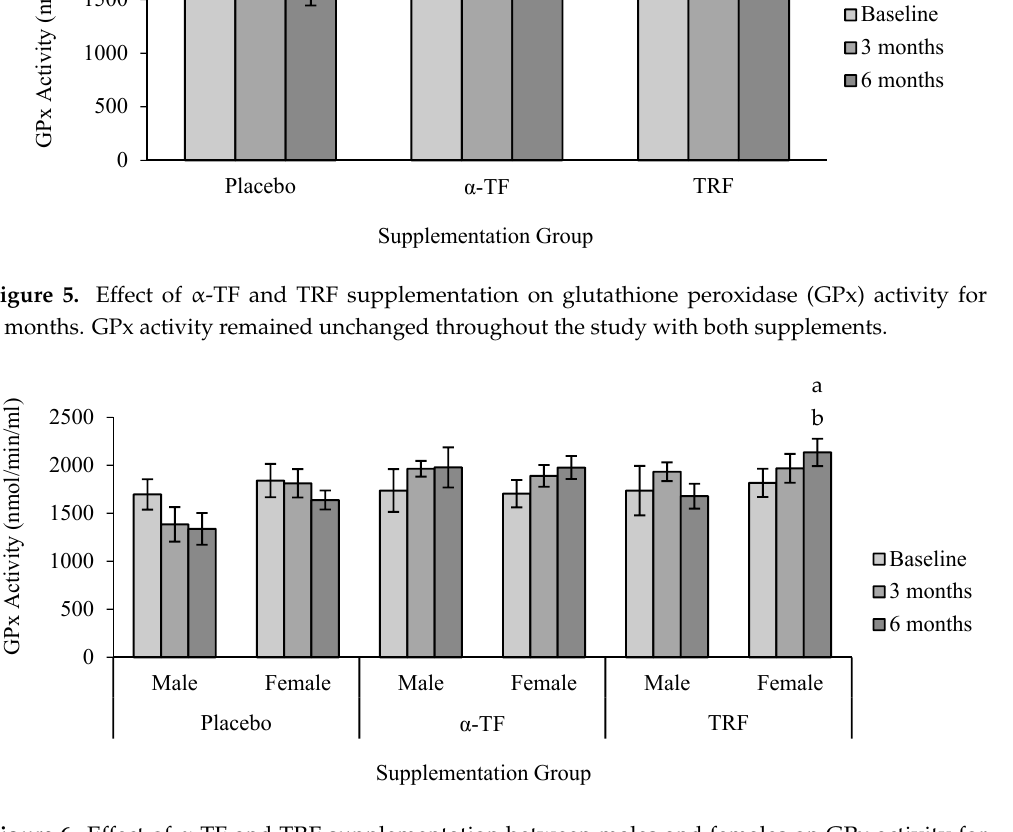
Figure 6. Effect of α -TF and TRF supplementation between males and females on GPx activity for 6 months. a = statistically significant compared to 0-month TRF group (female), b = statistically significant compared to 6 months TRF group (male), p < 0.05.